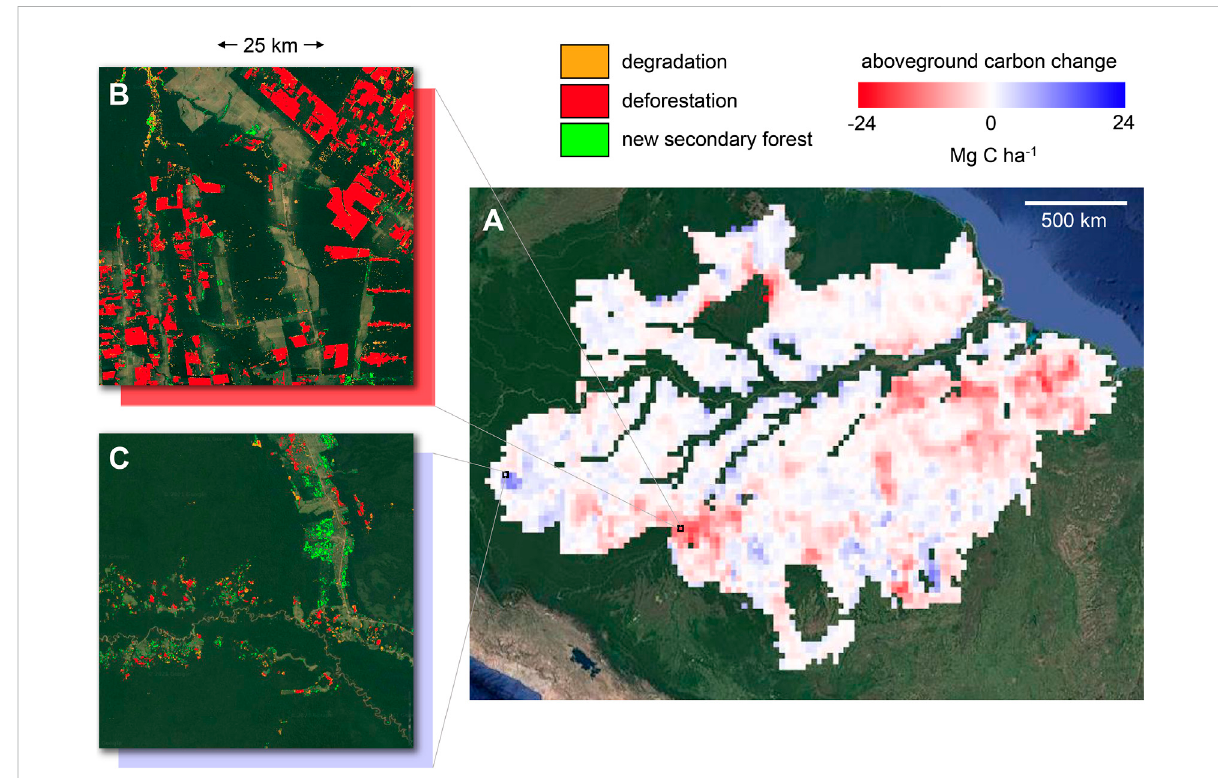
FIGURE 6 Remotely sensed carbon dynamics in the Brazilian Amazon and illustration of associated land-cover changes. (A) Net above-ground biomass carbon (AGC) difference map of the Brazilian Amazon between years 2014 and 2017. The AGC is derived using Vegetation Optical Depth in the L-band(L-VOD)from SMOS passivemicrowave observations(Wigneronetal.,2021), calibrated with theESAClimate Change Initiative2017 biomass map(SantoroandCartus,2021).High-resolution(30 m)mapping (B) ofcarbonlosspixelwithlarge,deforestedarea,and (C) ofcarbongainpixel with large intact forest fraction and forest regrowth. The observations help monitor and attribute gross changes in carbon stored in the above- ground land biosphere to human and natural drivers, thus contributing to theassessment of the integrity of carbon sinks and reservoirs. Importantly, systematic use of this approach could support veri fi cation of the ef fi cacy of REDD and carbon offsetting